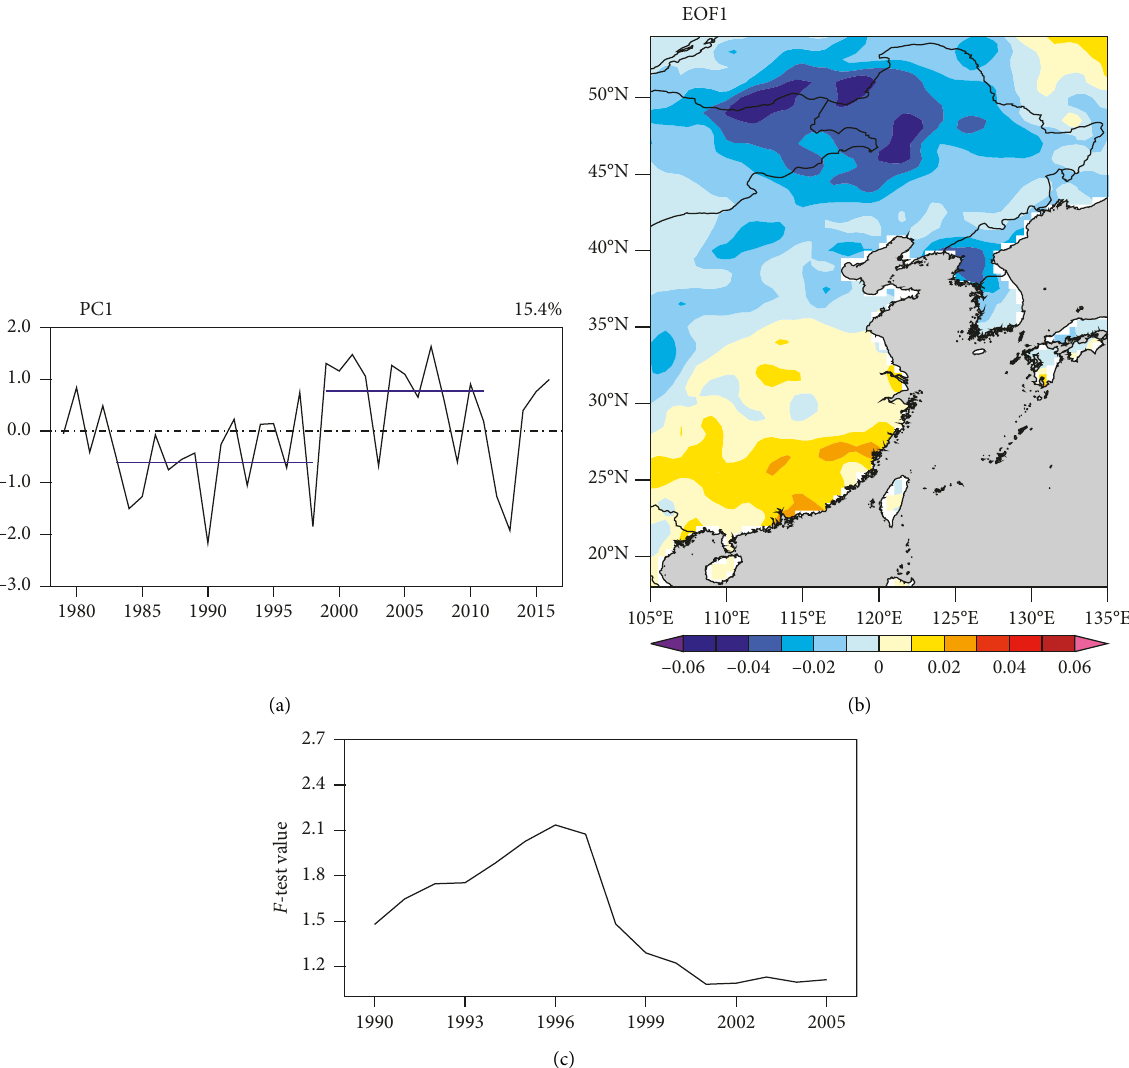
Figure 2: Normalized time series of the EOF1 (PC1) of the summer mean precipitation efficiency in East Asia during 1979–2016 (a), the spatial distribution of the EOF1 (b), and analysis of variance of PC1 variability (c). The percentage value at the top right in (a) denotes the explained variance of EOF1. Blue solid lines in (a) represent the abrupt changes in mean value between 1983–1998 and 1999–2013, and the dashed line is the zero